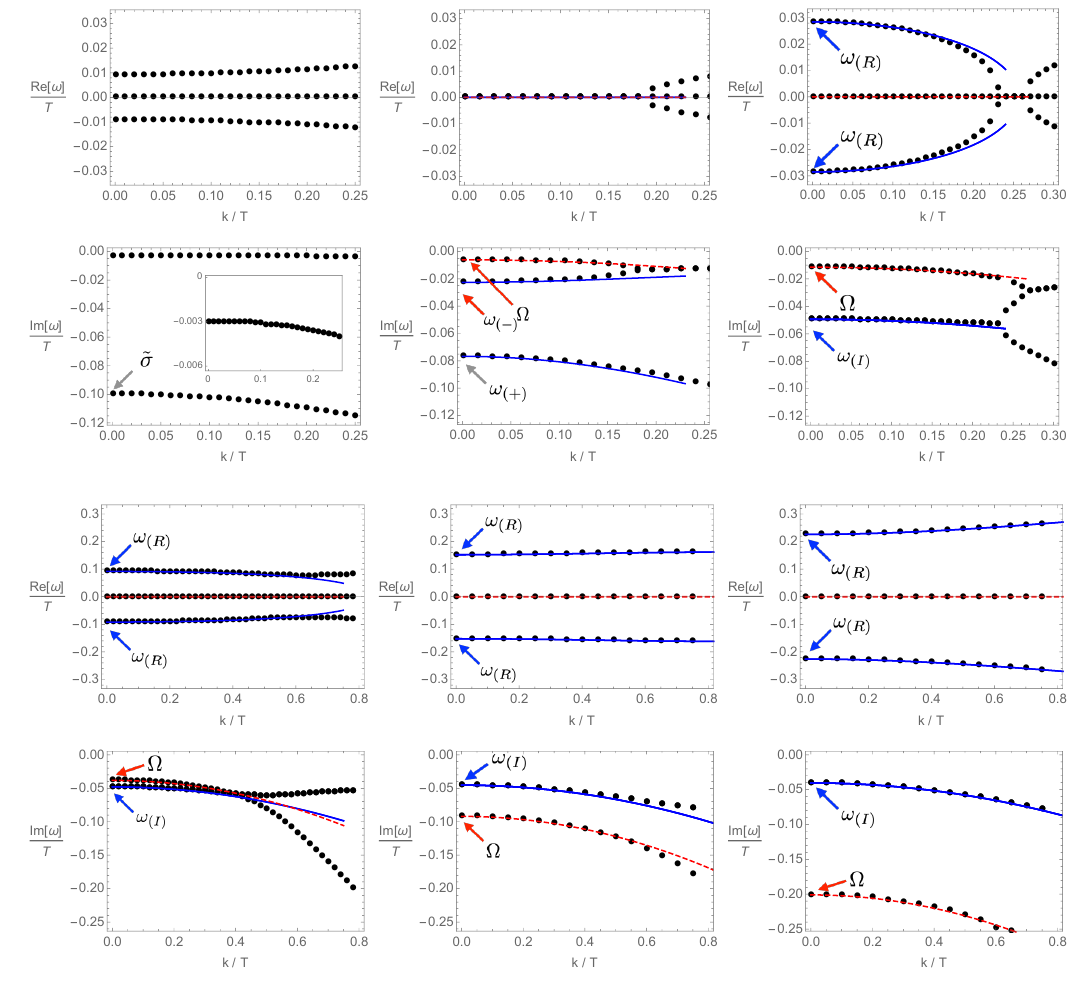
11 . Dispersion relation of the low-energy modes in the longitudinal spectrum. From top left to bottom right, the temperature decreases, T/T 1 . 00141 , 0 . 999438 , 0 . 998946 , 0 . 996497 , 0 . 991633 , 0 . 982048 . Each panel is associated to the corresponding imaginary part located below